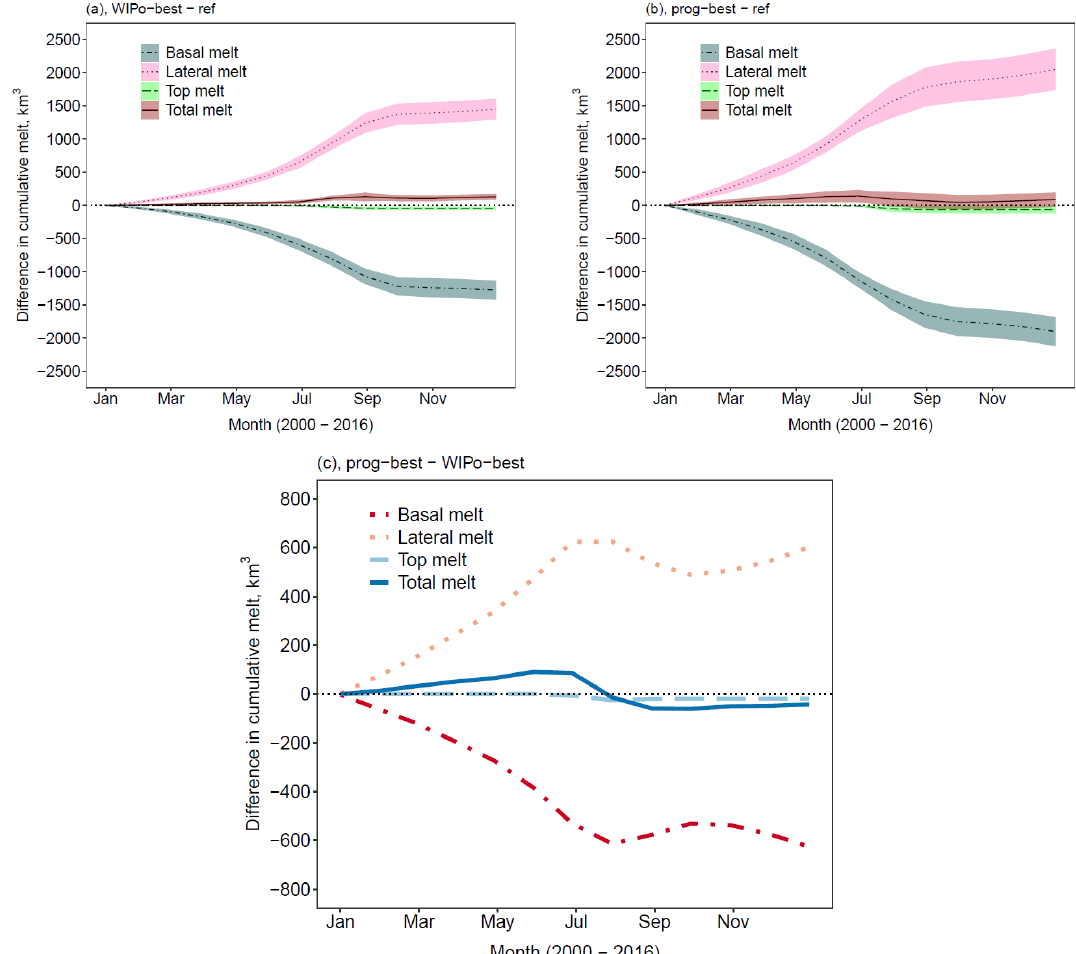
Figure 9. The top two plots show the difference in the cumulative lateral (pink ribbon, dotted), basal (grey ribbon, dotted–dashed), top (green ribbon, dashed), and total (red ribbon, solid) melt averaged over 2000–2016 for prog-best (b) and WIPo-best (a) relative to ref. The ribbon shows, in each case, the region spanned by the mean value plus or minus twice the standard deviation. The bottom plot shows the difference in the cumulative lateral (orange, dotted), basal (red, dotted–dashed), top (light blue, dashed), and total (dark blue, solid) melt averaged over 2000–2016 for prog-best relative to WIPo-best (c)